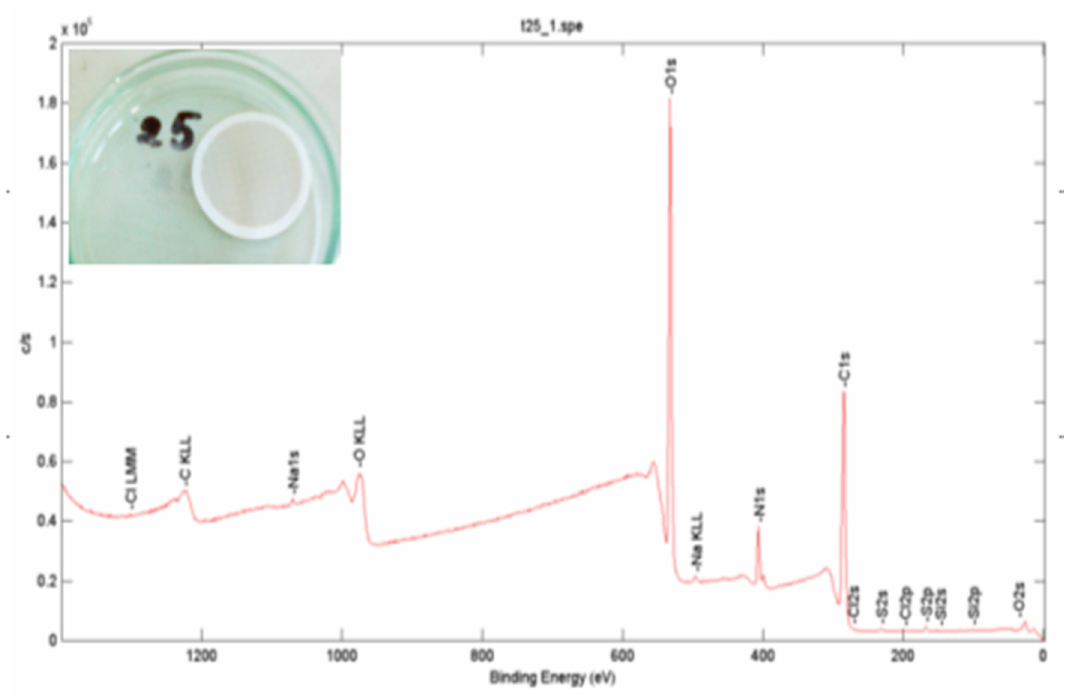
Figure 6. Example of the XPS spectrum in the energy range 0–1400 eV for the PM 4 in the house without smokers in Jaworzno.